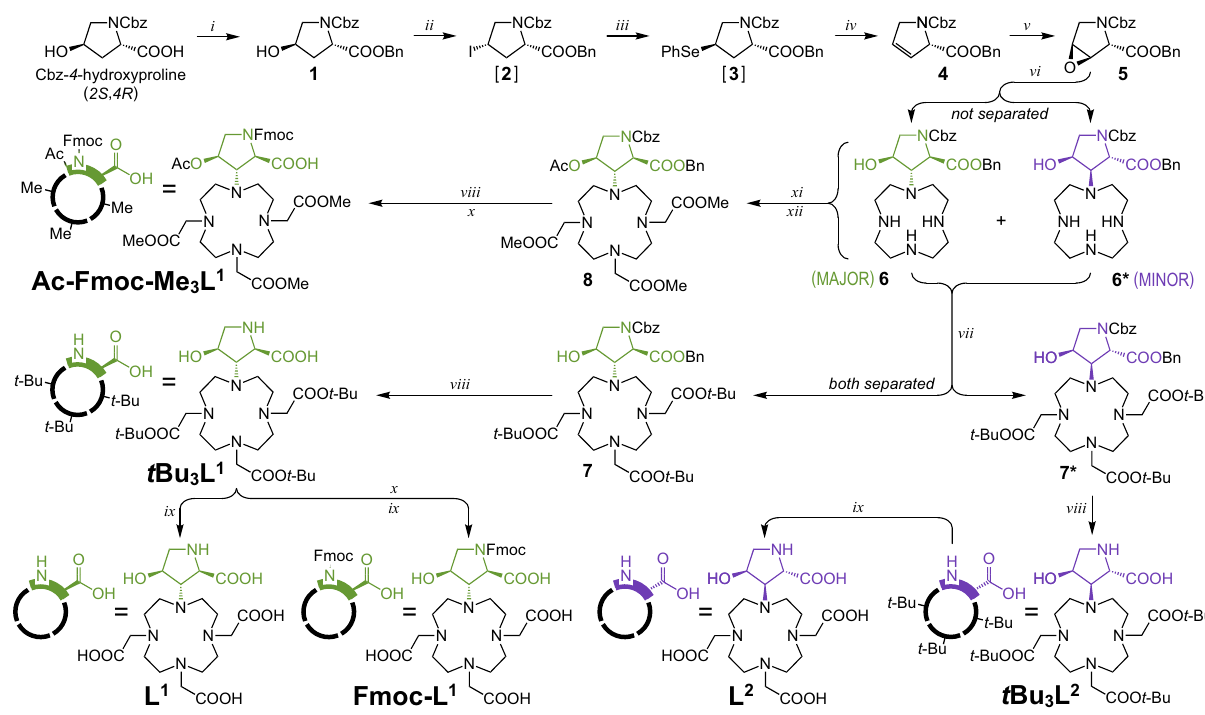
Fig. 3 Synthetic scheme for building blocks L 1 , L 2 , and their protected variants. Conditions: (i) BnBr (benzyl bromide), TEA (triethylamine), THF (tetrahydrofurane); (ii) PPh 3 , THF, 0 °C followed by DIAD (diisopropyl azodicarboxylate), MeI, 0 °C → RT; (iii) (PhSe) 2 , EtOH, NaBH 4 , 0 °C; (iv) H 2 O 2 , THF, 0 °C → RT; (v) MCPBA ( meta -chloroperoxybenzoic acid), CHCl 3 , 85 °C; (vi) cyclen, t -BuOH, 105 °C; (vii) t -BuO 2 CCH 2 Br, K 2 CO 3 , MeCN; (viii) H 2 , Pd@C, AcOH, MeOH; (ix) TFA; (x) FmocCl, aq. borate/NaOH buffer (pH 9.0), MeCN; (xi) MeO 2 CCH 2 Br, K 2 CO 3 , MeCN; (xii) Ac 2 O, TEA, DMAP ( 4 - dimethylaminopyridine), MeCN. Intermediates in brackets were not isolated. Colors de fi ne stereochemistry of the hydroxyproline moiety: 2R , 3S , 4S (green) and 2S , 3R , 4S (violet). Detailed synthetic procedures are provided in Supplementary Figs. 22 – 36.